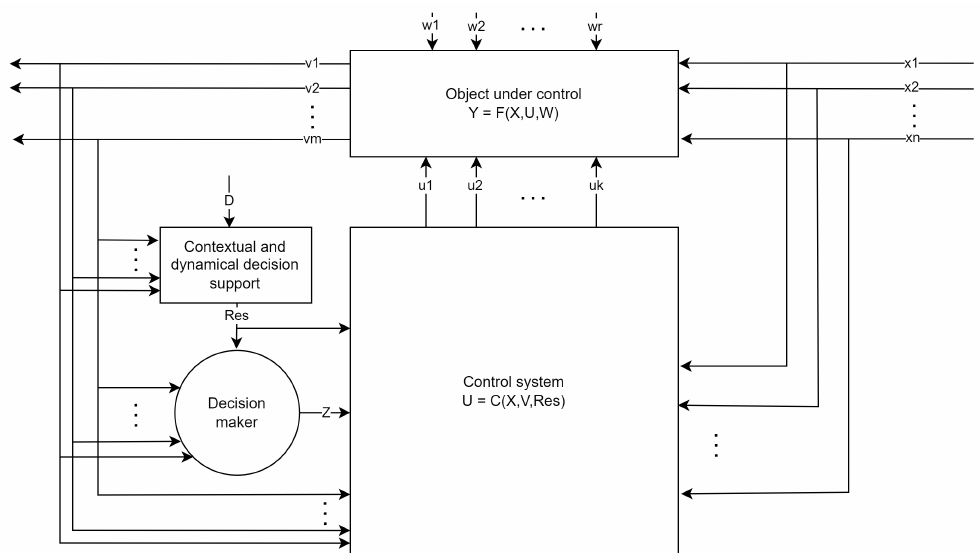
Figure 2. Modified scheme of the control